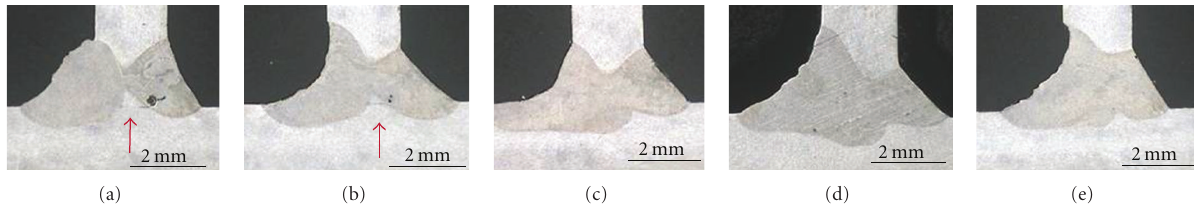
Figure 5: Macrographs of the weld seams obtained using di ff erent laser power of CO 2 laser (fixed welding parameter: υ = 4m/min). (a) 6.8KW, (b) 7.2 KW, (c) 7.5KW, (d) 7.8KW, and (e) 8.0KW.